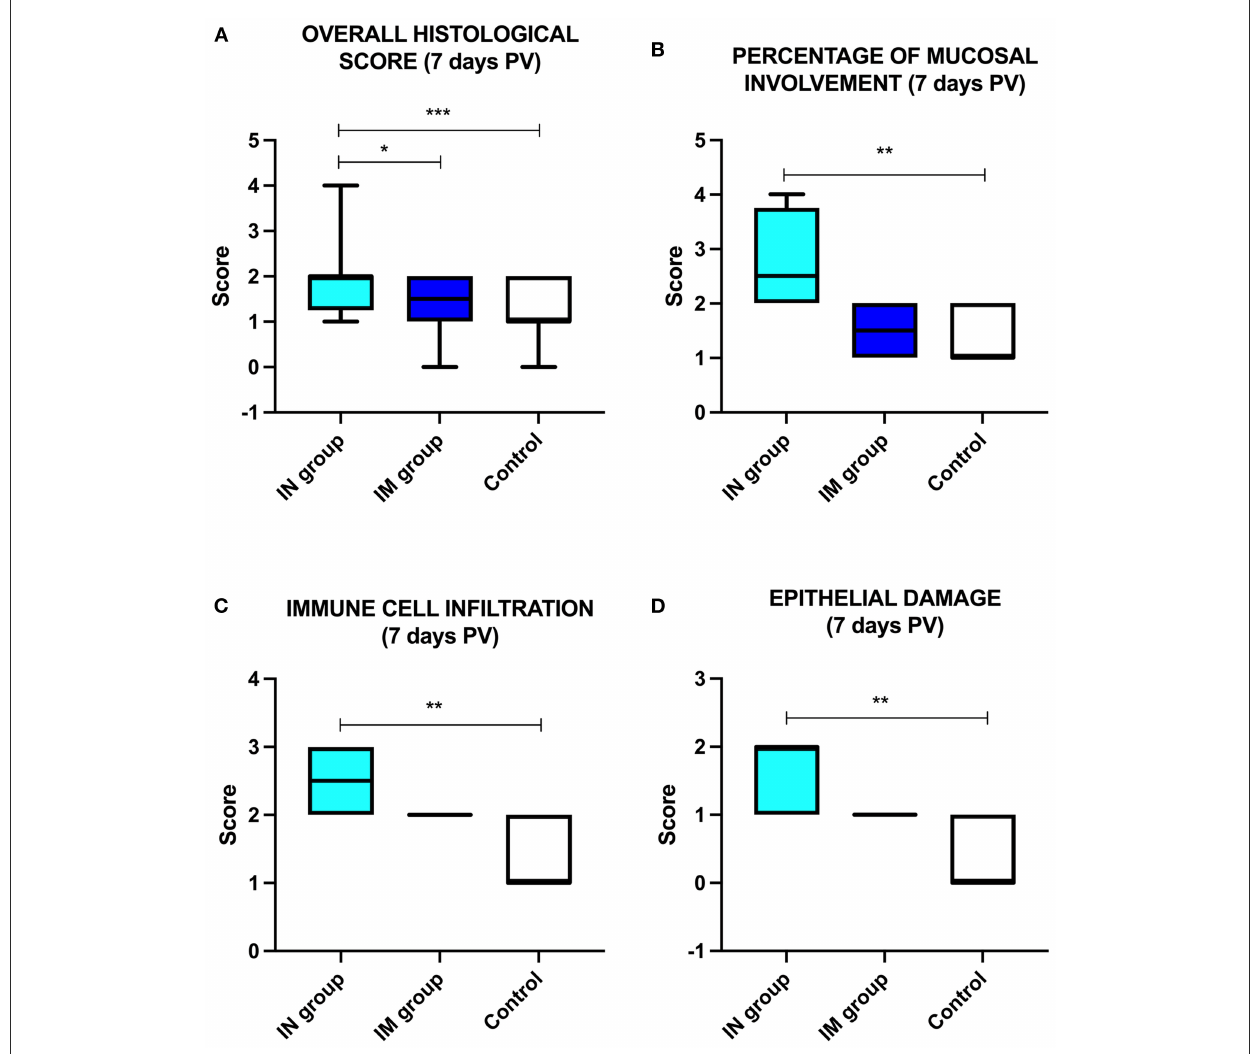
FIGURE6 Histological analysis. Schematic representation of (A) the overall histological score in the control group, IN-vaccinated group (nano-adjuvanted dry powder vaccine) and IM-vaccinated group at 7 days PV; (B) percentage of mucosal involvement, (C) immune cell infiltration and (D) epithelial damage in the control group, IN-vaccinated group and IM-vaccinated group. * p < 0.05; ** p < 0.01; *** p < 0.001. IN, intranasally; IM, intramuscularly; PV,